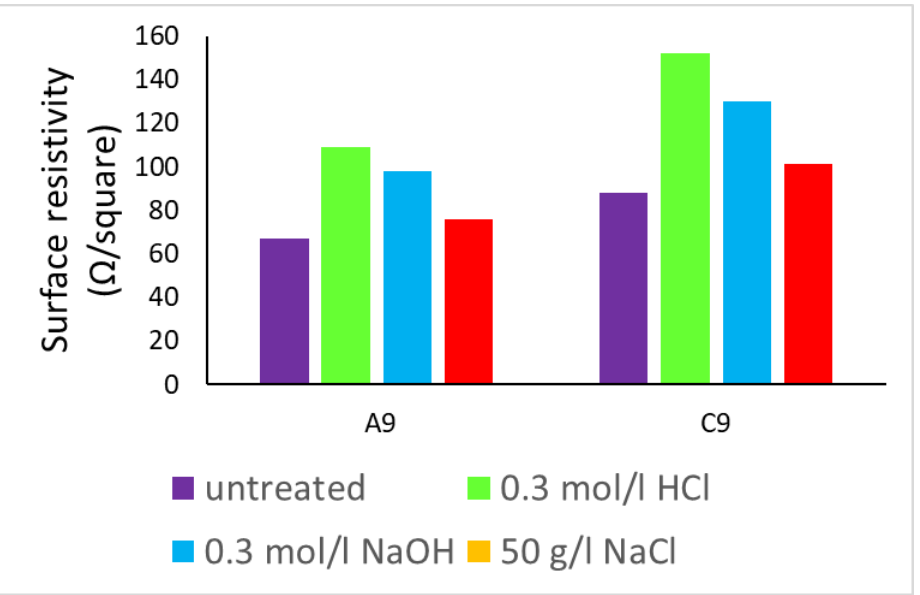
Figure 19. The comparison of electrical resistivity values before and after chemical treatment for Copper electroplated